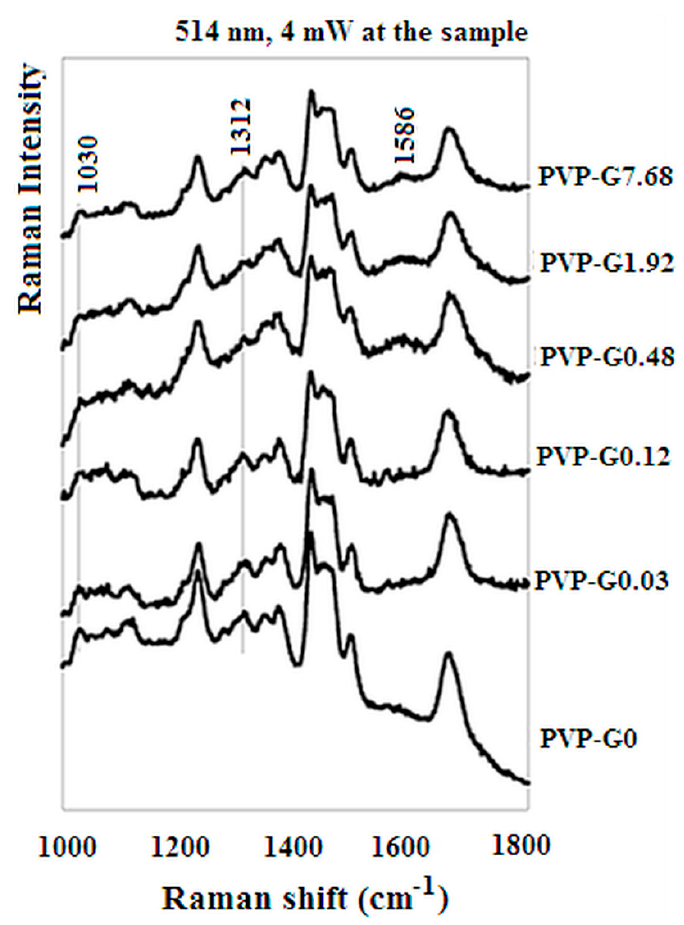
Figure 8. Raman spectra of the PVP tissues with different graphene content (PVP-G0.03, PVP-G0.12, PVP-G0.48, PVP-G1.92, PVP-G7.68) (excitation wavelength 514 nm, 4 mW at the sample).